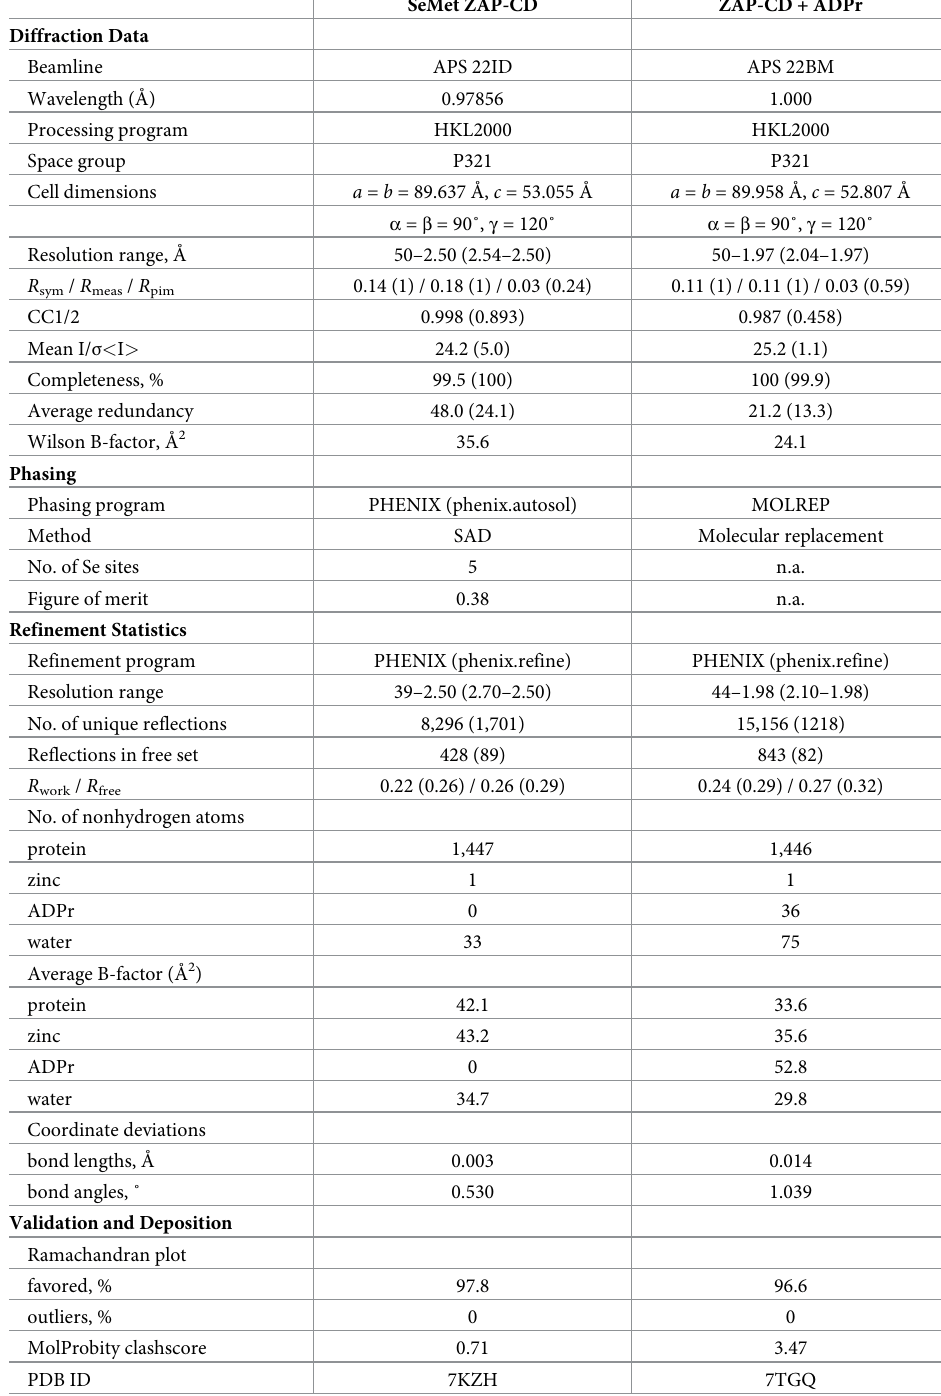
Table 1. Crystallographic